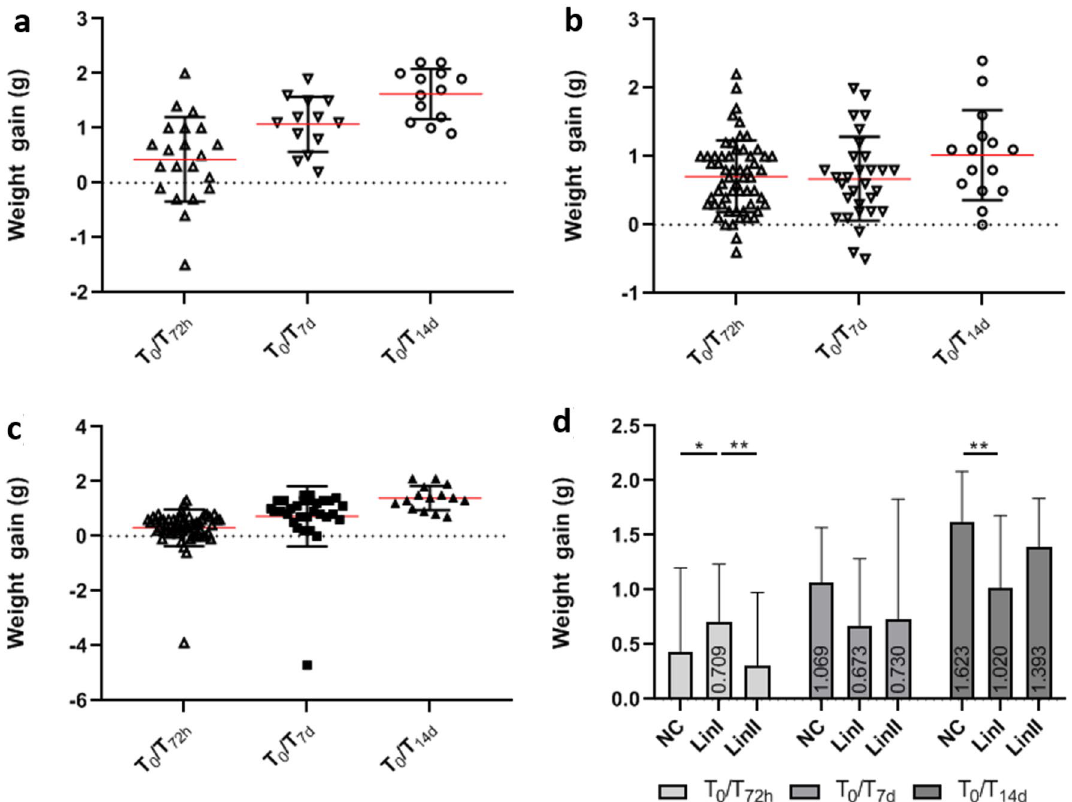
Figure 1. Body weight gain of BALB/c mice uninfected and infected with DENV-2 Lineages before infection